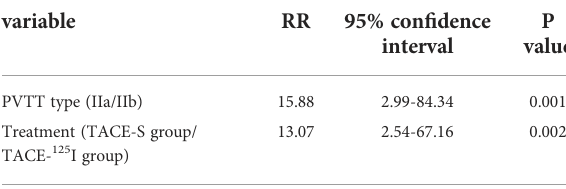
TABLE 6 Multivariate Analysis of In fl uencing APFs